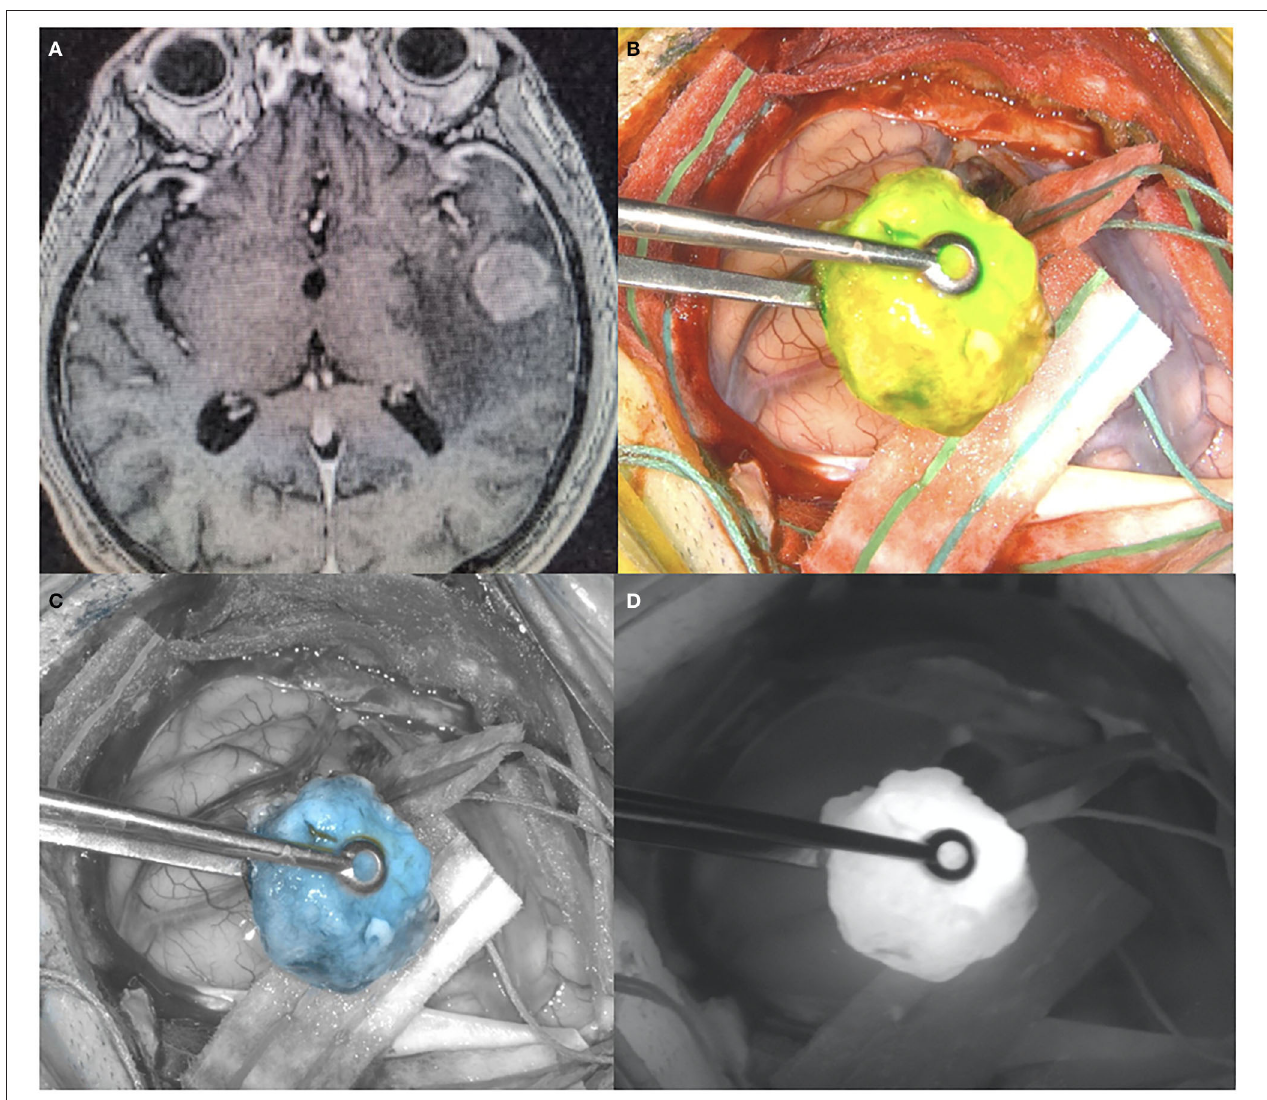
FIGURE 1 | (A) Pre-operative T1 post-contrast MR, showing a left temporal lesion with surrounding vasogenic edema. Histological diagnosis showed a metastatic lung adenocarcinoma. (B) Intraoperative picture during the surgical removal of the same case depicted in (A) , showing the ICG uptake by the tumor visualized with yellow-green excitation. (C) Intraoperative picture during the surgical removal of the same case depicted in (A) , showing the ICG uptake by the tumor with blue excitation. (D) Intraoperative picture during the surgical removal of the same case depicted in (A) , showing the ICG uptake by the tumor visualized with near-infrared